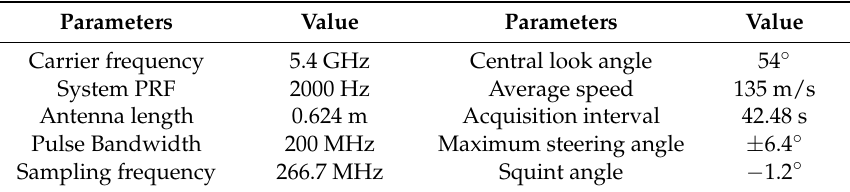
Table 1. Main system and processing parameters for the experiment.